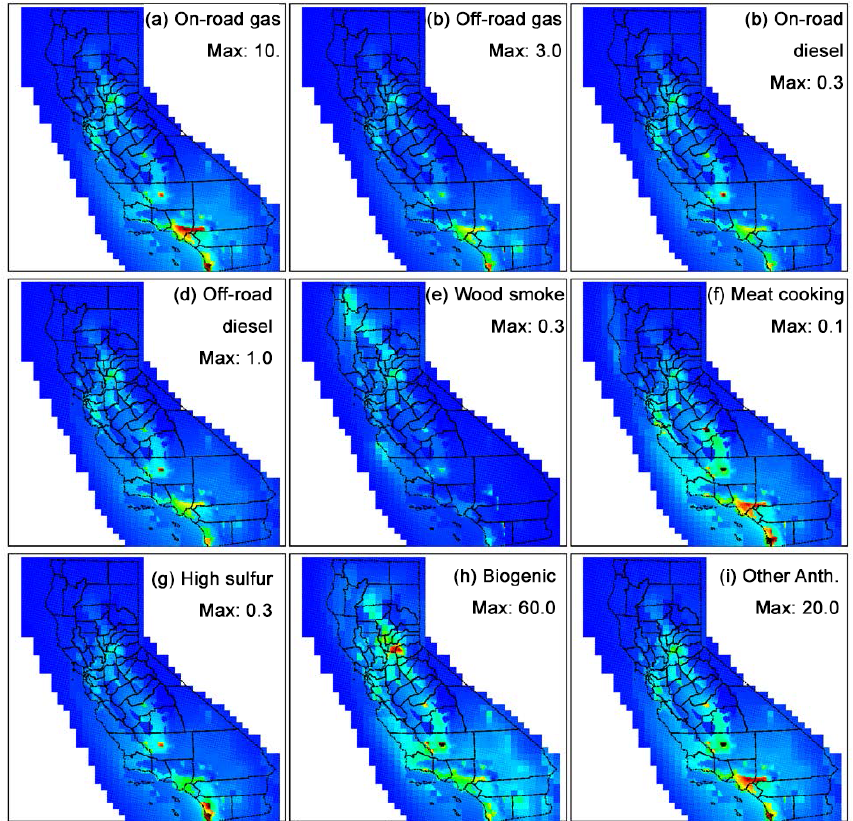
Figure 8. Predicted source contributions to 9-year average PM 0 . 1 SOA concentrations. The definition of the color scales is the same as